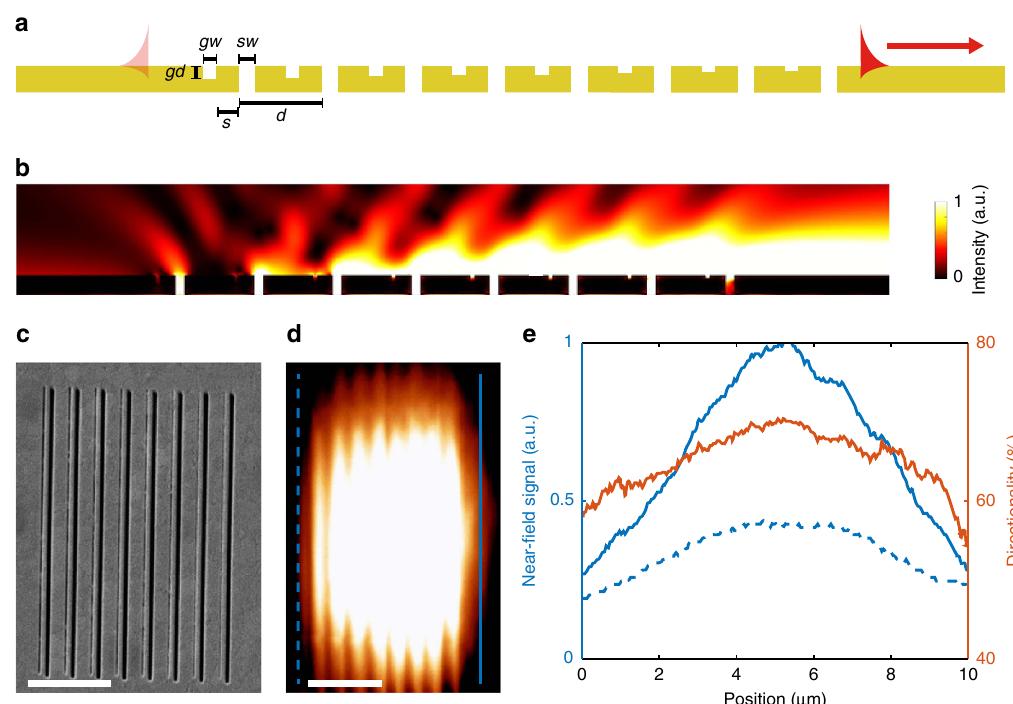
Figure 4 | Directional SPP excitation on a VCSEL. ( a ) Schematic of a slit-groove coupler with period d , slit width sw , groove width gw , separation s and groove depth gd . ( b ) Simulated intensity distribution of the SPP modes excited under normal illumination from below for the structure with parameters d ¼ 800nm, sw ¼ 100nm, gw ¼ 50nm and s ¼ 150nm. A linear decrease of groove depth is introduced from left to right, decreasing the SPP reflectivity. The illuminating light is polarized perpendicularly to the grooves. ( c ) Scanning electron microscope image of the slit-groove coupler milled into a plasmonic VCSEL. ( d ) Near-field intensity distribution measured above the coupler and the SPP waveguide with the cross-sections shown in e . ( e ) The cross-sections of the SPP intensity profile to the right (solid blue line) and left (dashed blue line) from the coupler, measured from the scanning near-field optical microscopy image in d , and the directionality parameter (red line). Directionality is defined as the ratio of the SPP power flowing to the right divided by the total SPP power. Scale bars, 2.5 m m in ( c , d ). a.u., arbitrary